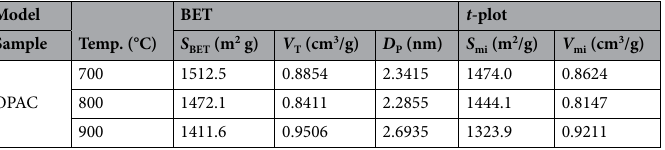
Table 1. Influence of carbonization temperature on the volume of pores and surface area of